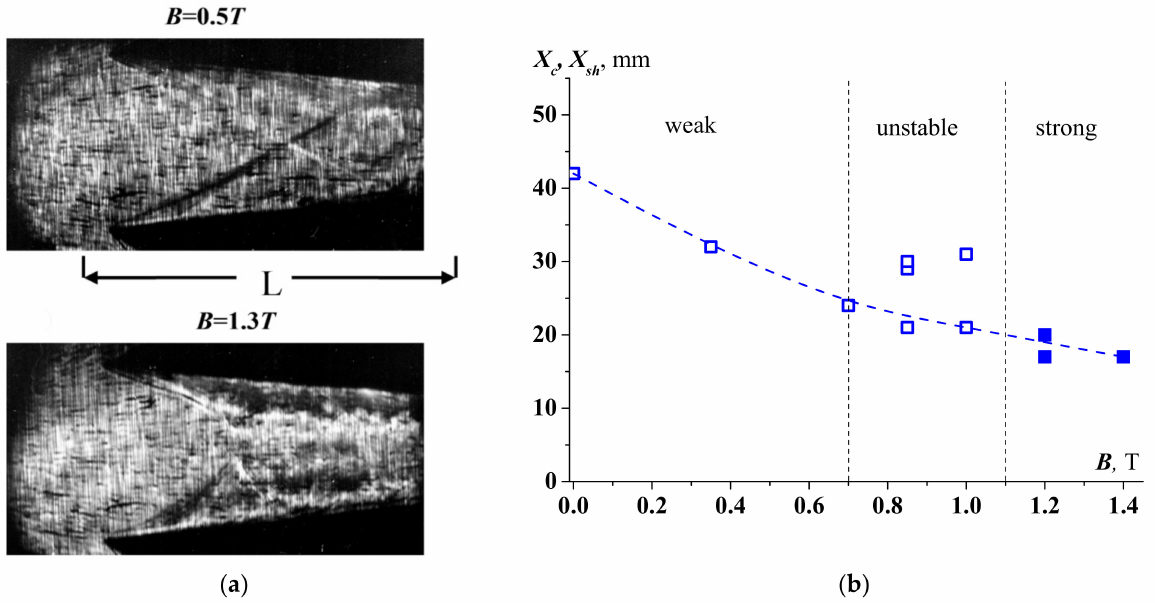
Figure 8. ( a ) Schlieren patterns of flow during interaction in the entire diffuser, j 3 , 4,5,6,7 = 7 × 10 5 A/m 2 ; ( b ) The position of the regular intersection of the attached shocks X c (open points) and shock of the MHD deceleration X sh (filled